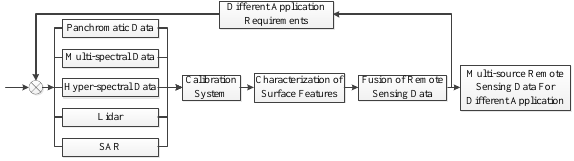
Figure 5. The application of cybernetics in multi-source remote sensing information